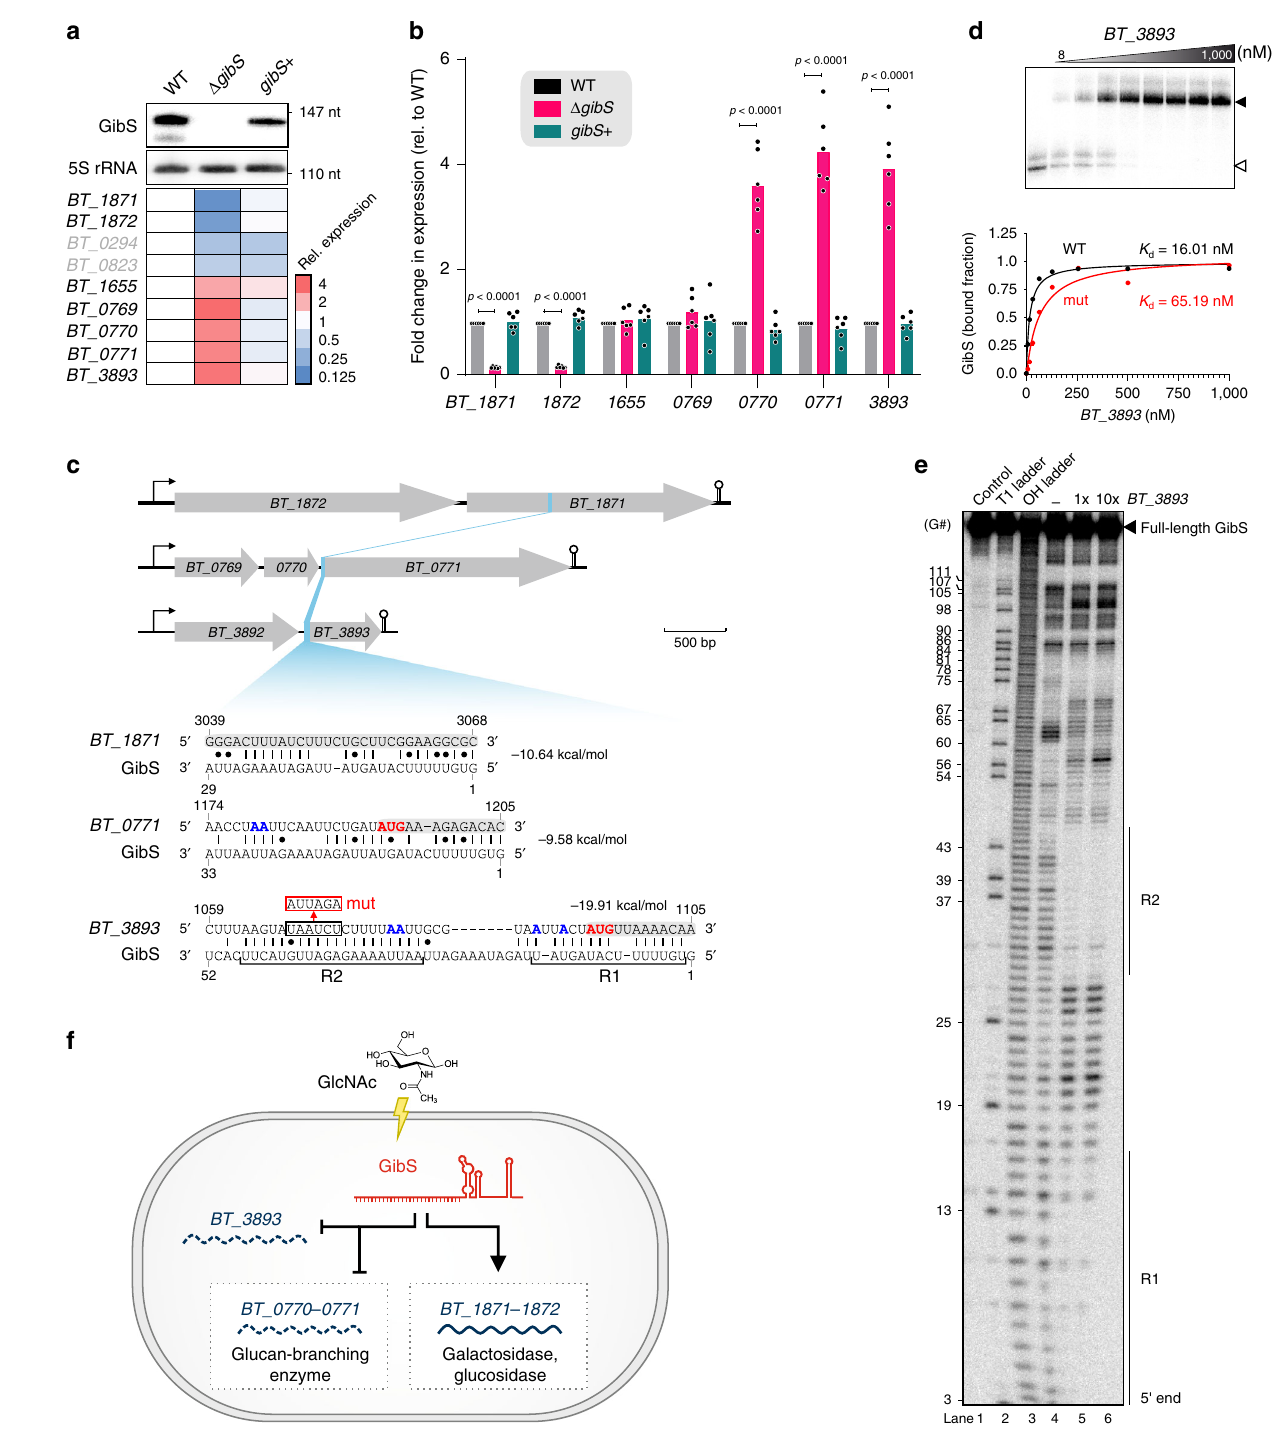
adjacent regions in the 5 ′ portion of GibS (termed R1 and R2 in Fig. 5c), and mutating a hexameric sequence within the BT_3893 region targeted by R2 reduced its af fi nity to GibS (Fig. 5d; Supplementary Fig. 8b). In contrast, the in vitro interaction of GibS with BT_1871 , for which binding was proposed to occur within the CDS, was of very low af fi nity (Supplementary Fig. 8c). This argues that in the bacterial cell, base-pairing between GibS and BT_1871 may depend on auxiliary factors, such as a RNA chaperone, or that activation of this gene by GibS (Fig. 5a, b) is